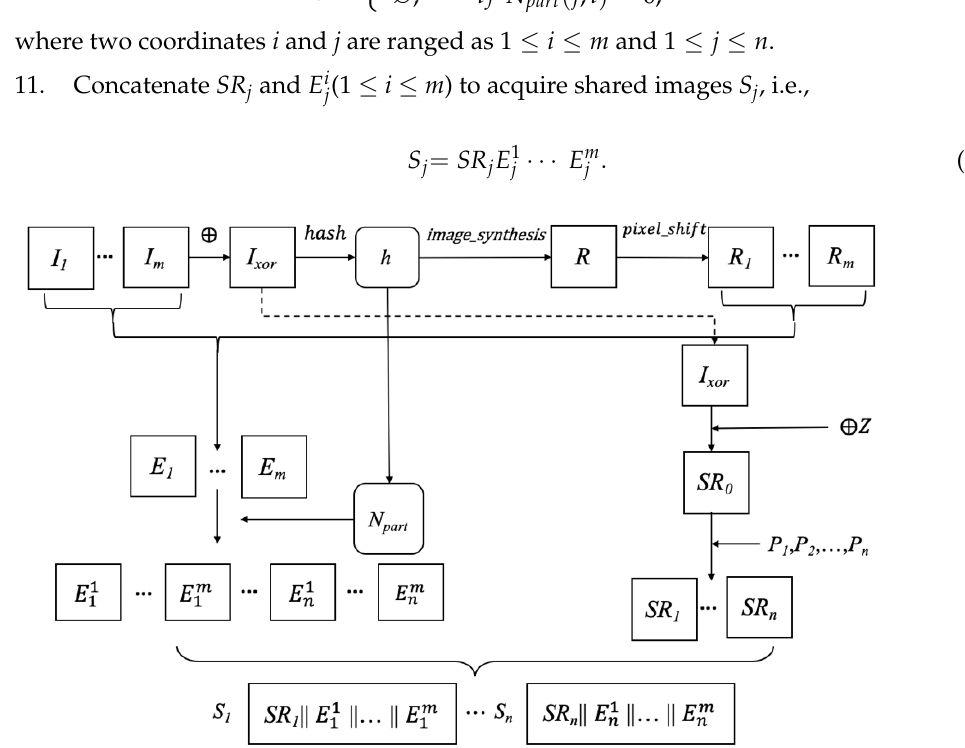
Figure 6. Processes of the second proposed source-random-separate ( SRS ) algorithm. The proposed SRS method shares XOR result I XOR and the randomlike images R i (1 ≤ i ≤ m ) with secret images I i (1 ≤ i ≤ m ) separately. Especially, in Step 10, the images 𝐸 𝑖 are selected according to the 𝑁 𝑝𝑎𝑟𝑡 matrix. Assume in the proposed (3, 4, 5) SRS method [1 with the encrypted images E i (1 i 5) and the matrix 𝑁 𝑝𝑎𝑟𝑡 = concatenation of images 𝐸 𝑖 is acquired from the matrix element of 𝑁 𝑝𝑎𝑟𝑡 . In the first row, the 1st and 3rd elements being 1 leads to share 𝐸 1𝑖 (1 𝑖 5) = {𝐸 1 , ∅, 𝐸 3 , ∅, ∅}. From the